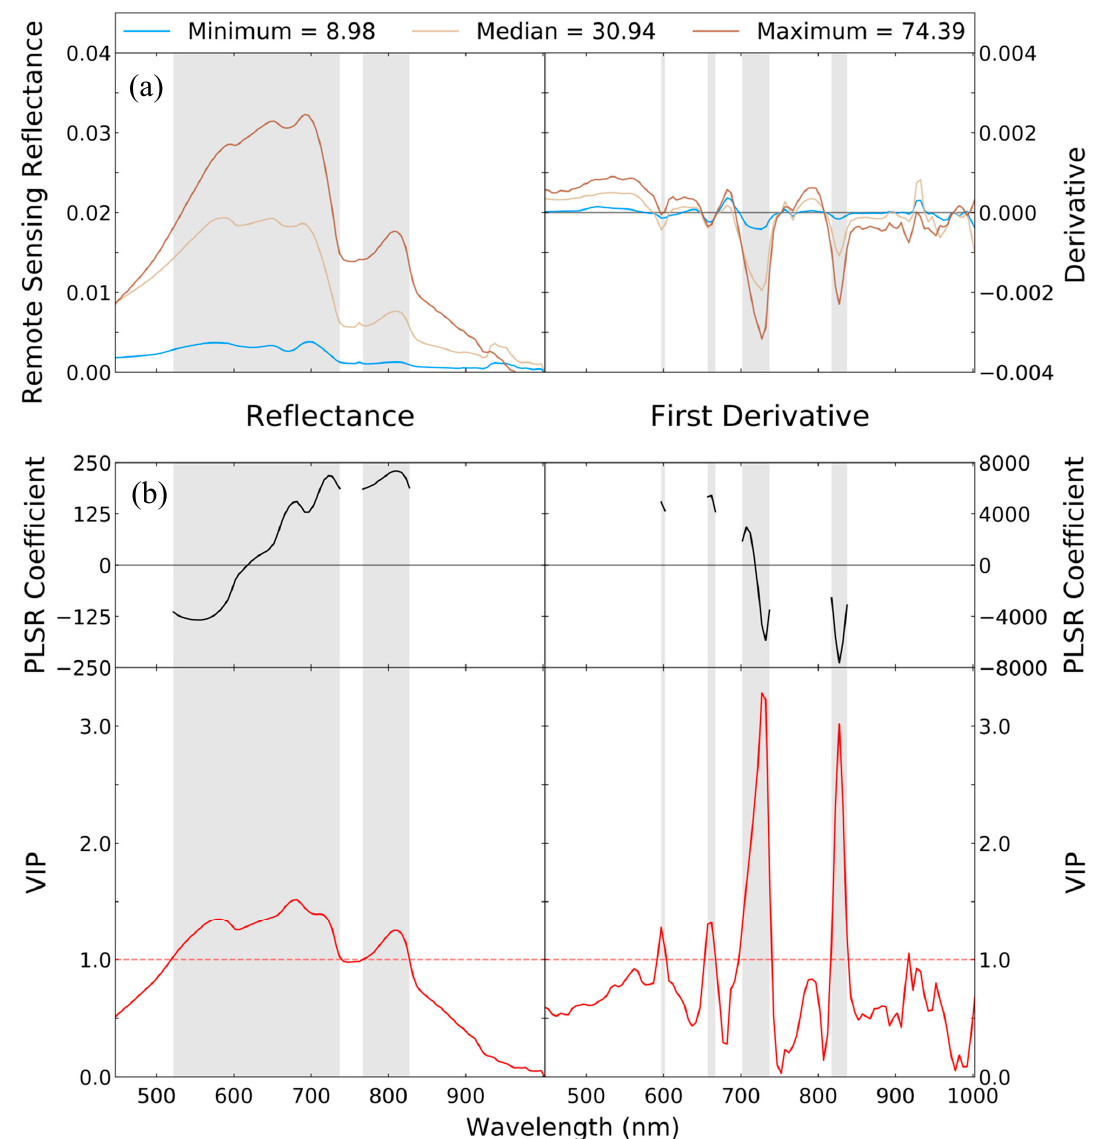
Figure 2. ( a ) Sample spectra plots for the 2016 Louisiana field spectrometer reflectance measurements (left), representing the paired spectra for the sample set’s minimum (8.98 mg/L), median (30.94 mg/L), and maximum (74.39 mg/L) TSS measurements, and the corresponding first derivatives (right). ( b ) Partial least squares regression (PLSR) model summaries for simulated Airborne Visible–Infrared Imaging Spectrometer ‐ Next Generation (AVIRIS ‐ NG) reflectance and first derivative. The red lines indicate the Variable Importance in Projection value at each band (bottom) for the initial PLSR model, and the black lines (top) indicate the models’ coefficient value for each utilized band (also reported in Table A1). Shaded regions indicate the utilized wavelengths in the final PLSR models, where the associated Variable Importance in Projection (VIP) > 1.